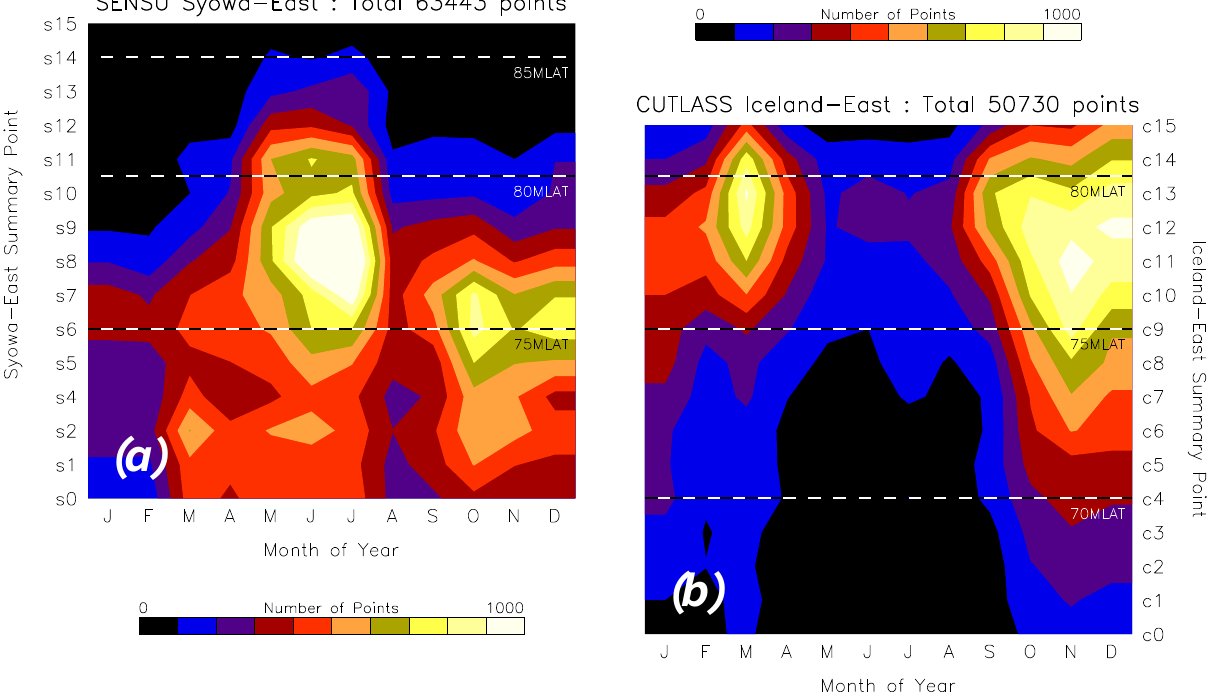
Fig. 2. Color-coded number of data points as a function of month obtained by (a) SENSU Syowa-East radar and (b) CUTLASS Iceland-East radar during the interval of our statistical analysis. The vertical axis indicates the summary points from S0 to S15 for Syowa-East and C0 to C15 for Iceland-East, and the horizontal axis is the month of the